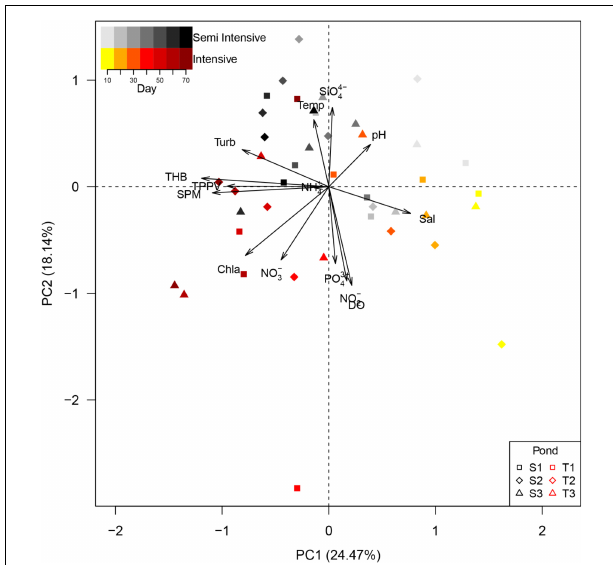
FIGURE 1 | Principal Component Analysis of environmental parameters and bacterial abundances in intensive (T) and semi intensive (S) systems. Point shape indicates replicate pond of the same system. Increasing color intensity indicates rearing time. SPM, suspended particulate matter; THB, total heterotrophic bacteria; TPPV, total potential pathogenic Vibrio ; NH 4 + , ammonium; Turb, turbidity; Temp, temperature; SiO 44 − , silicate; Sal, salinity; PO 43 + , phosphate; NO 2 − , nitrite; DO, dissolved oxygen; NO 3 − , nitrate; Chl a, chlorophyll a.